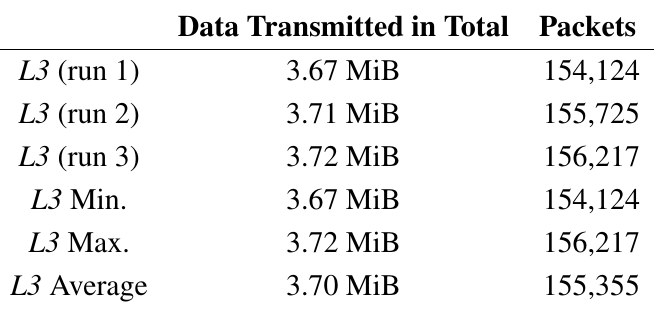
Table 6. Data transmission statistics for L3 .